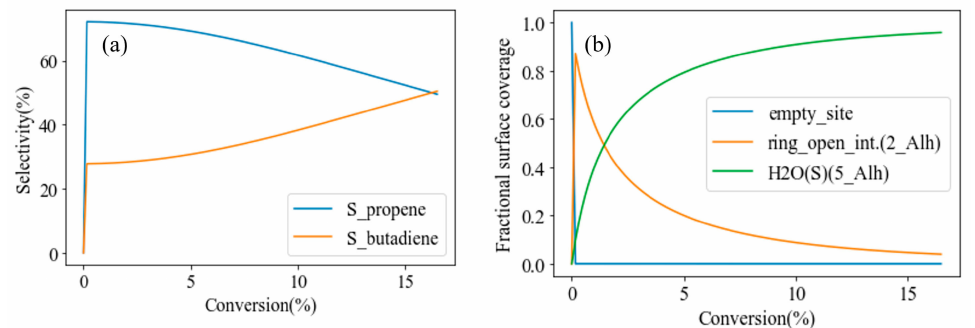
Figure 5. Microkinetic analysis corresponding to the hydroxylated Al 2 O 3 model: ( a ) selectivity of butadiene and propene vs. conversion, and ( b ) surface coverages in predominant species vs. conversion.